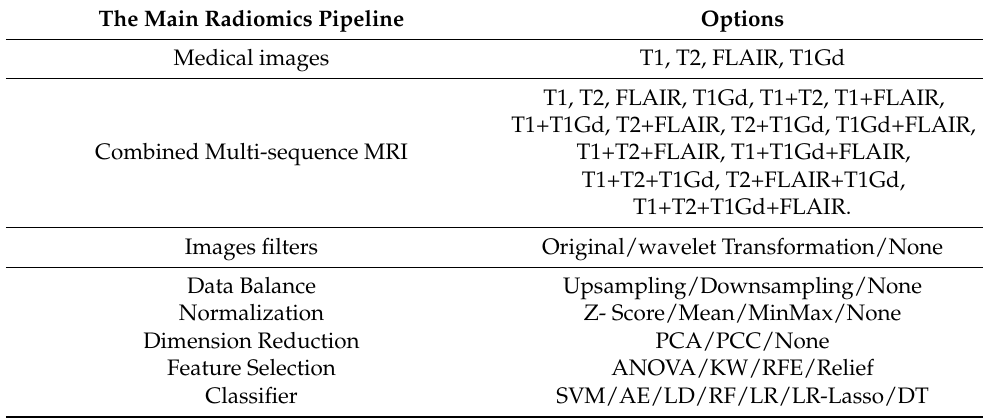
Table 1. Different options in the main radiomics pipeline of the “6-Step” general model (taking T1, T2, FLAIR, and T1Gd four MRI sequences, for example). The Main Radiomics Pipeline Options Medical images T1, T2, FLAIR, T1Gd T1, T2, FLAIR, T1Gd, T1+T2, T1+FLAIR, T1+T1Gd, T2+FLAIR, T2+T1Gd, T1Gd+FLAIR, Combined Multi-sequence MRI T1+T2+FLAIR, T1+T1Gd+FLAIR, T1+T2+T1Gd, T2+FLAIR+T1Gd, T1+T2+T1Gd+FLAIR. Images filters Original/wavelet Transformation/None Data Balance Upsampling/Downsampling/None Normalization Z- Score/Mean/MinMax/None Dimension Reduction PCA/PCC/None Feature Selection ANOVA/KW/RFE/Relief Classifier